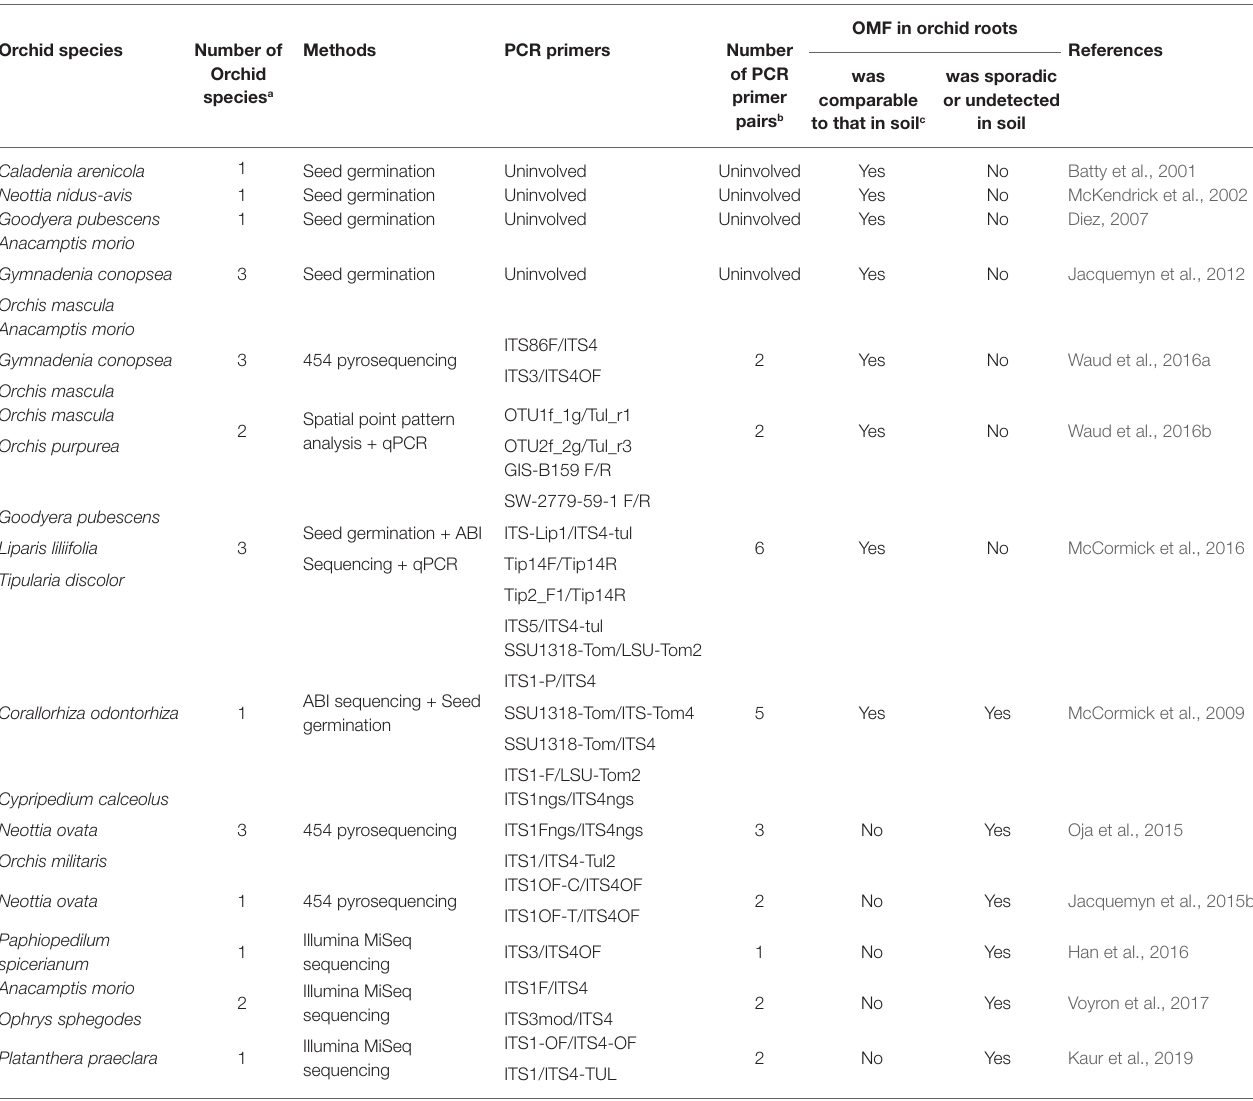
TABLE 1 | Comparison of OMF in orchid roots and